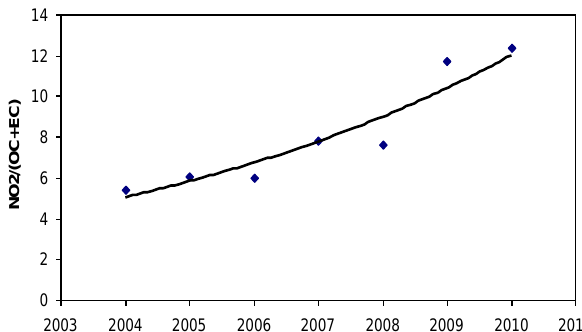
02468101214 Fig. 10. NO 2 /(OC+EC) rates as obtained from OC+EC mea- Figure 10. NO 2 /(OC+EC) rates as obtained from OC+EC measurements in PM2.5 surements in PM 2 . 5 performed at the Barcelona urban background performed at the Barcelona urban background site and from NO 2 measured at another urban background site in Barcelona (Ciutadella) by the Air Quality Department of the site and from NO 2 measured at another urban background site in Autonomous Region of Catalonia. Barcelona (Ciutadella) by the Air Quality Department of the Au- tonomous Region of